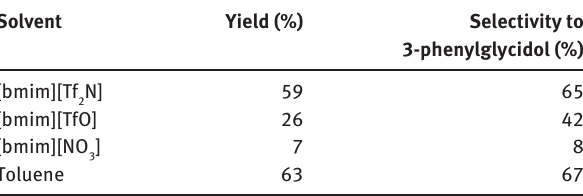
Table 2 Epoxidation reaction of cinnamyl alcohol in different